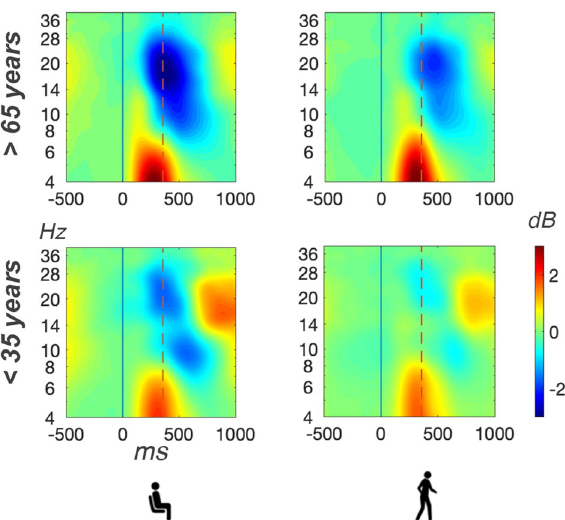
Figure 4. Mean ERSPs over both centrolateral clusters for older participants (upper row) and younger participants (lower row) during sitting (left column) and walking (right column). ERSP trials were time-warped with respect to the stimulus onset (time point zero, solid line in black) and the mean button press response time (356 ms after stimulus onset, dashed vertical line in